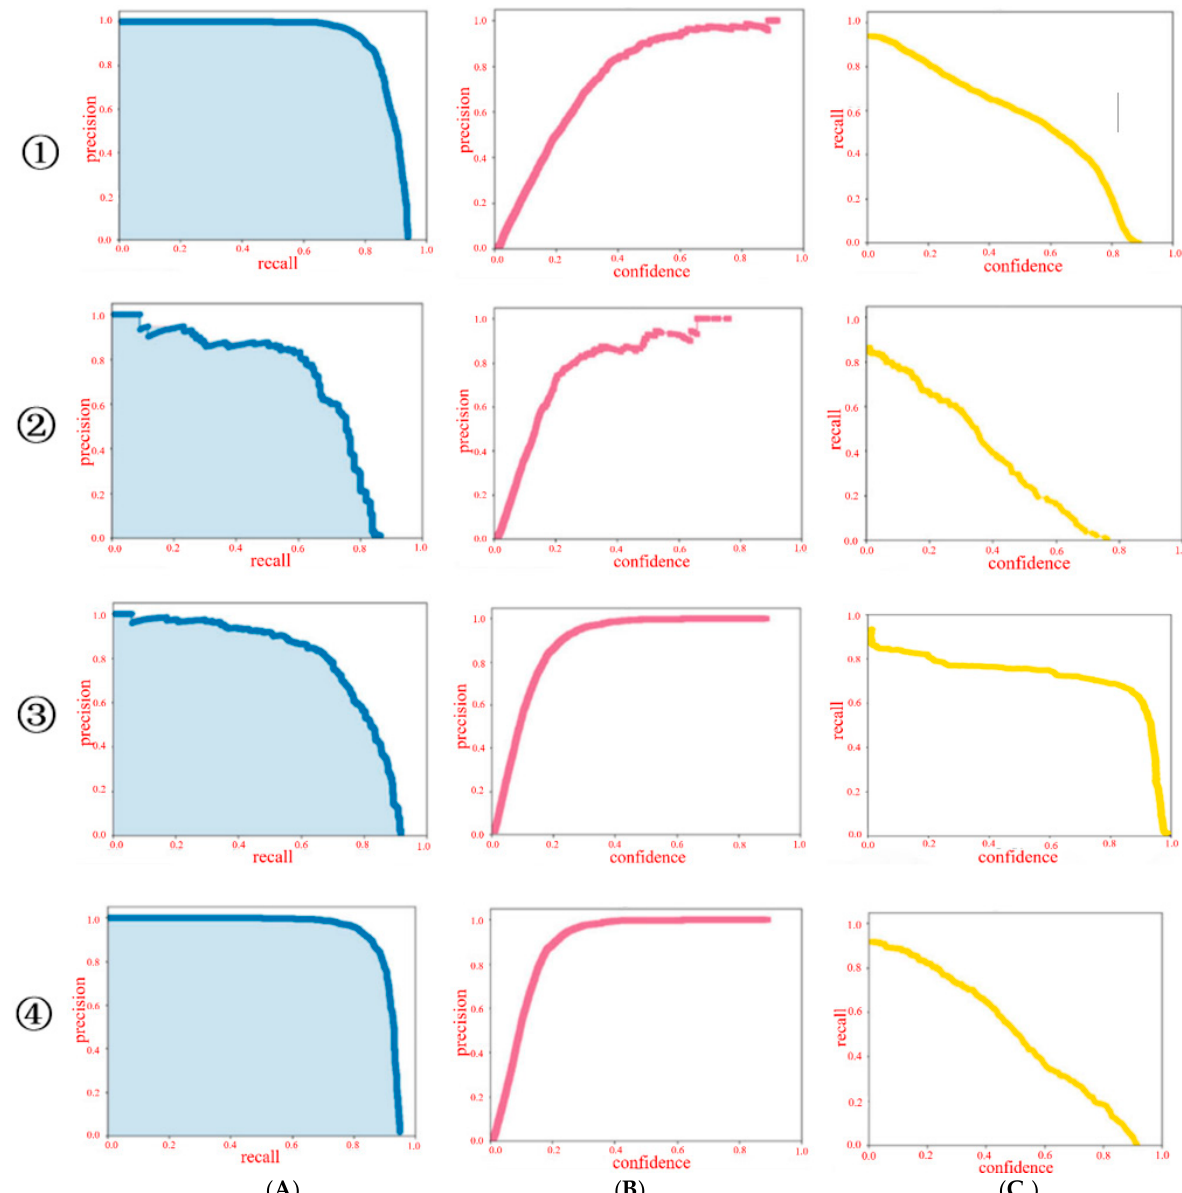
Figure 18. Evaluation index curve of each model. ( A ) P-R curve; ( B ) the accuracy-confidence threshold curve; ( C ) the recall-confidence threshold curve.